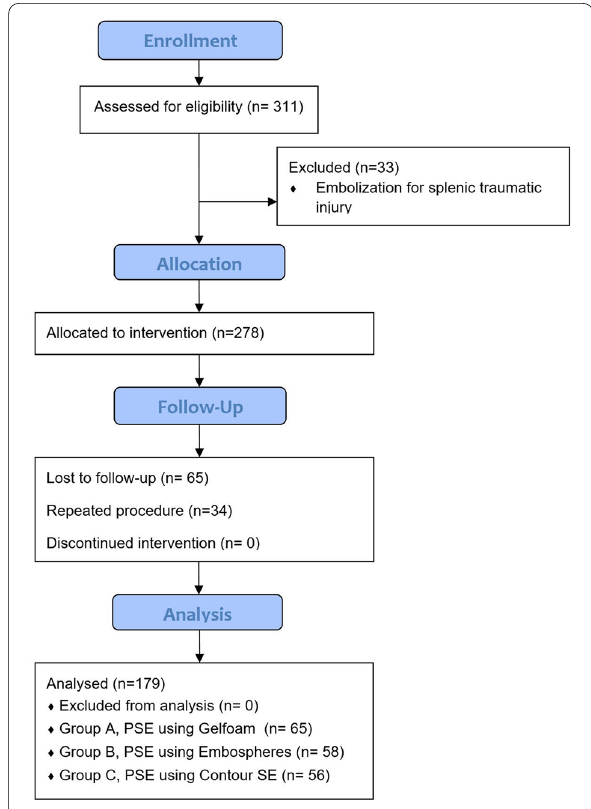
Fig. 1 Consort flow chart of the